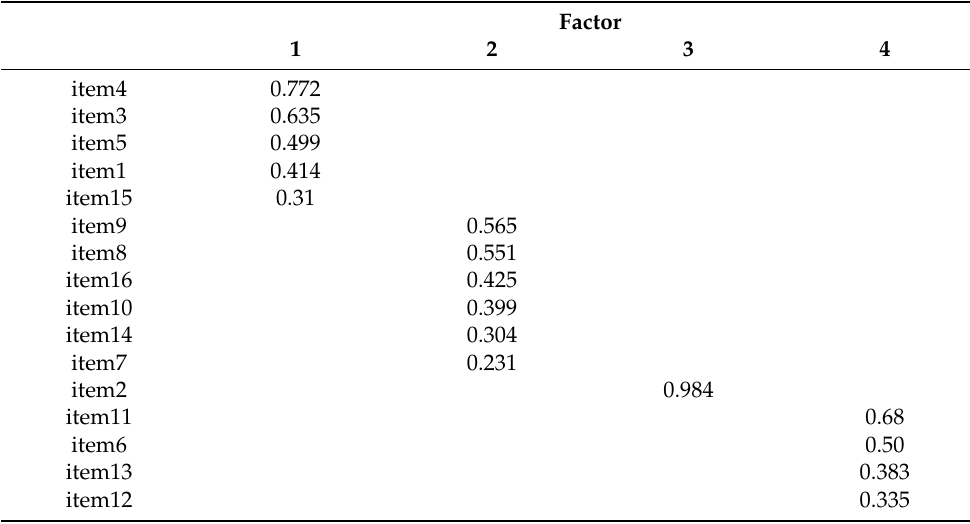
Table 1. Factor loadings for the Hungarian version of WCQ.